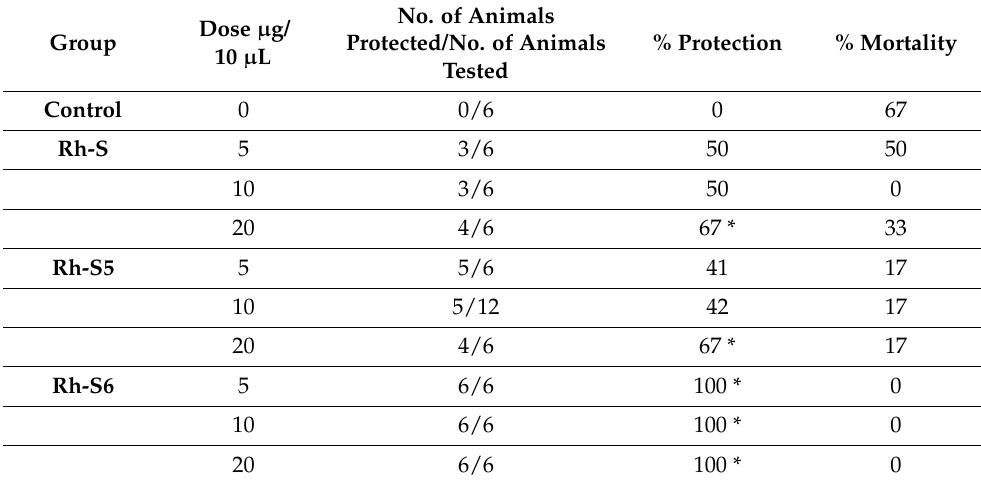
Table 6. The activity of Rh-S, Rh-S5, and Rh-S6 in MES test in mice.